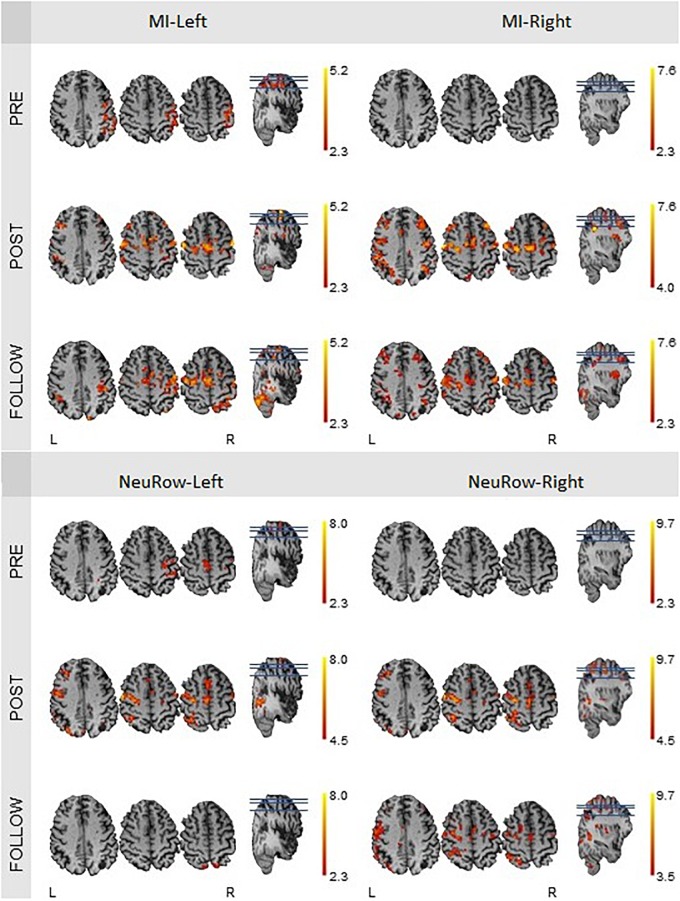
fMRI activation maps of the motor imagery condition for the left and right hand, at the pre-intervention, post-intervention and follow-up recording sessions. The Nvox and Zmax values are associated with the hemisphere contralateral to the hand. All maps have a threshold at Z > 2.3, except for the one of the motor-imagery of the right hand at the post-intervention (Z > 4.0), because of the substantial higher Zmax.